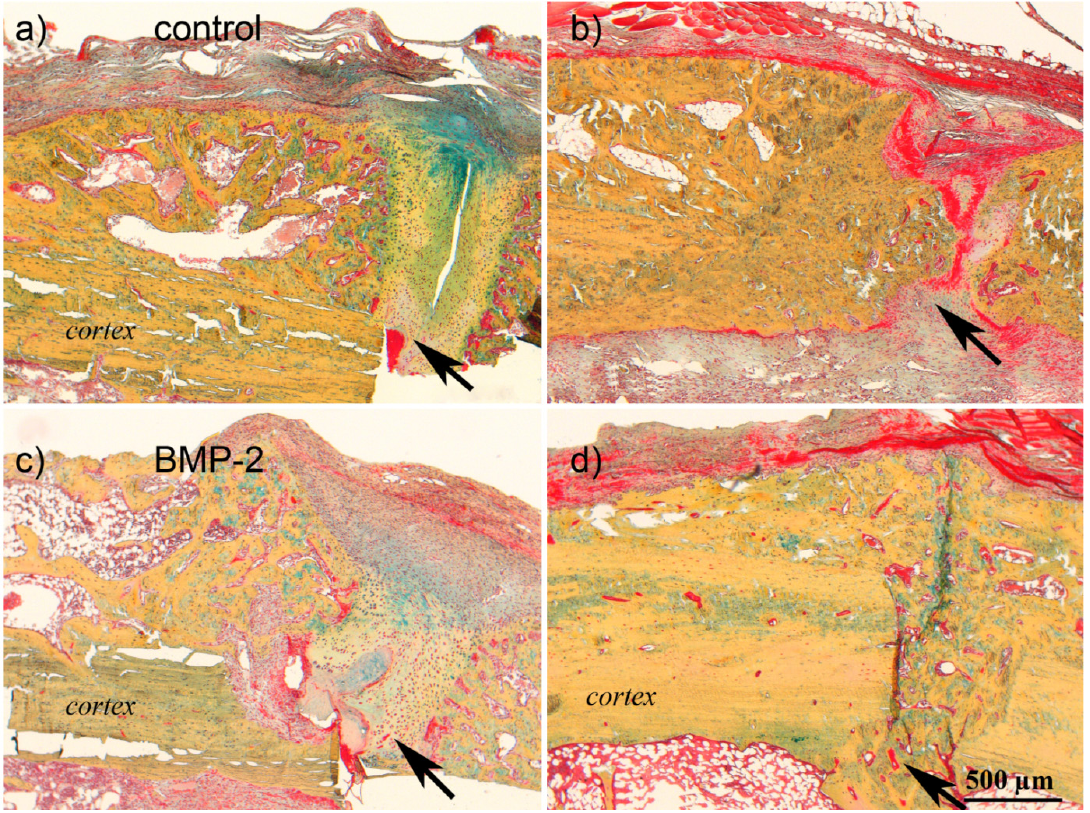
Figure 3. Histological staining of the calluses of the control and the BMP-2 group at Days 28 and 84. Movat pentachrome stainings of the two groups (control group: a , b ; and BMP-2 group: c , d ) at Days 28 ( a , c ) and 84 ( b , d ). The arrows point to the osteotomy gap. At Day 28, the calluses of both groups showed no fully mineralized bridging, as fibrous tissue was still filling the gap above the osteotomy. After 84 days, the healing progressed with fully mineralized callus in the BMP-2 group. Scale bar: 500